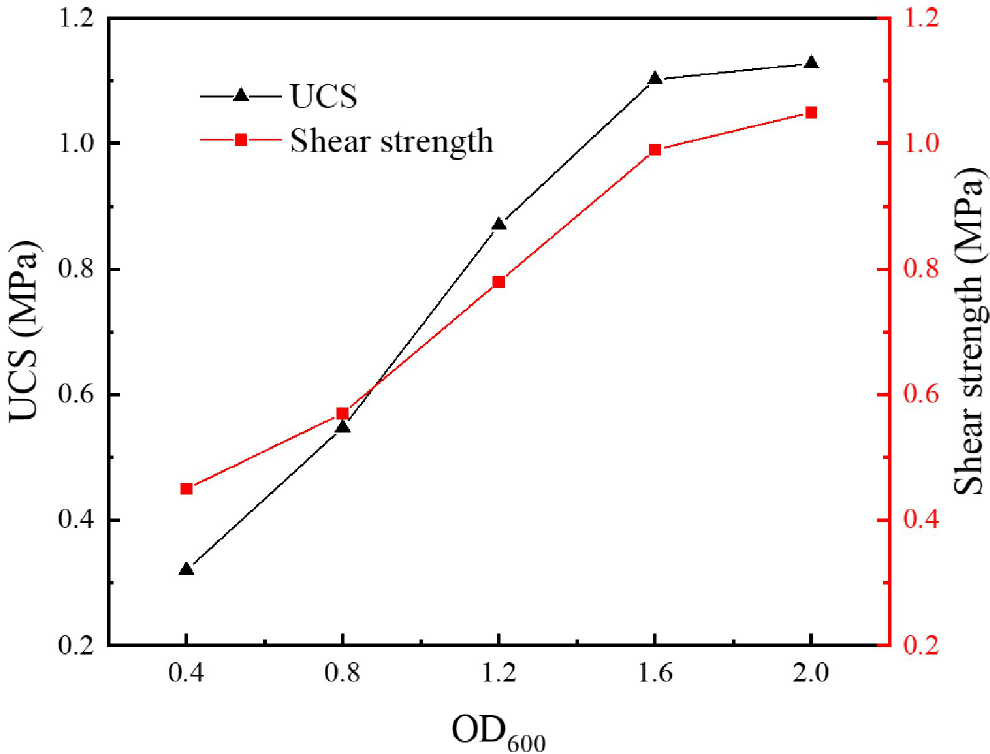
Fig 7. Relationship between bacterial solution concentration and mechanical